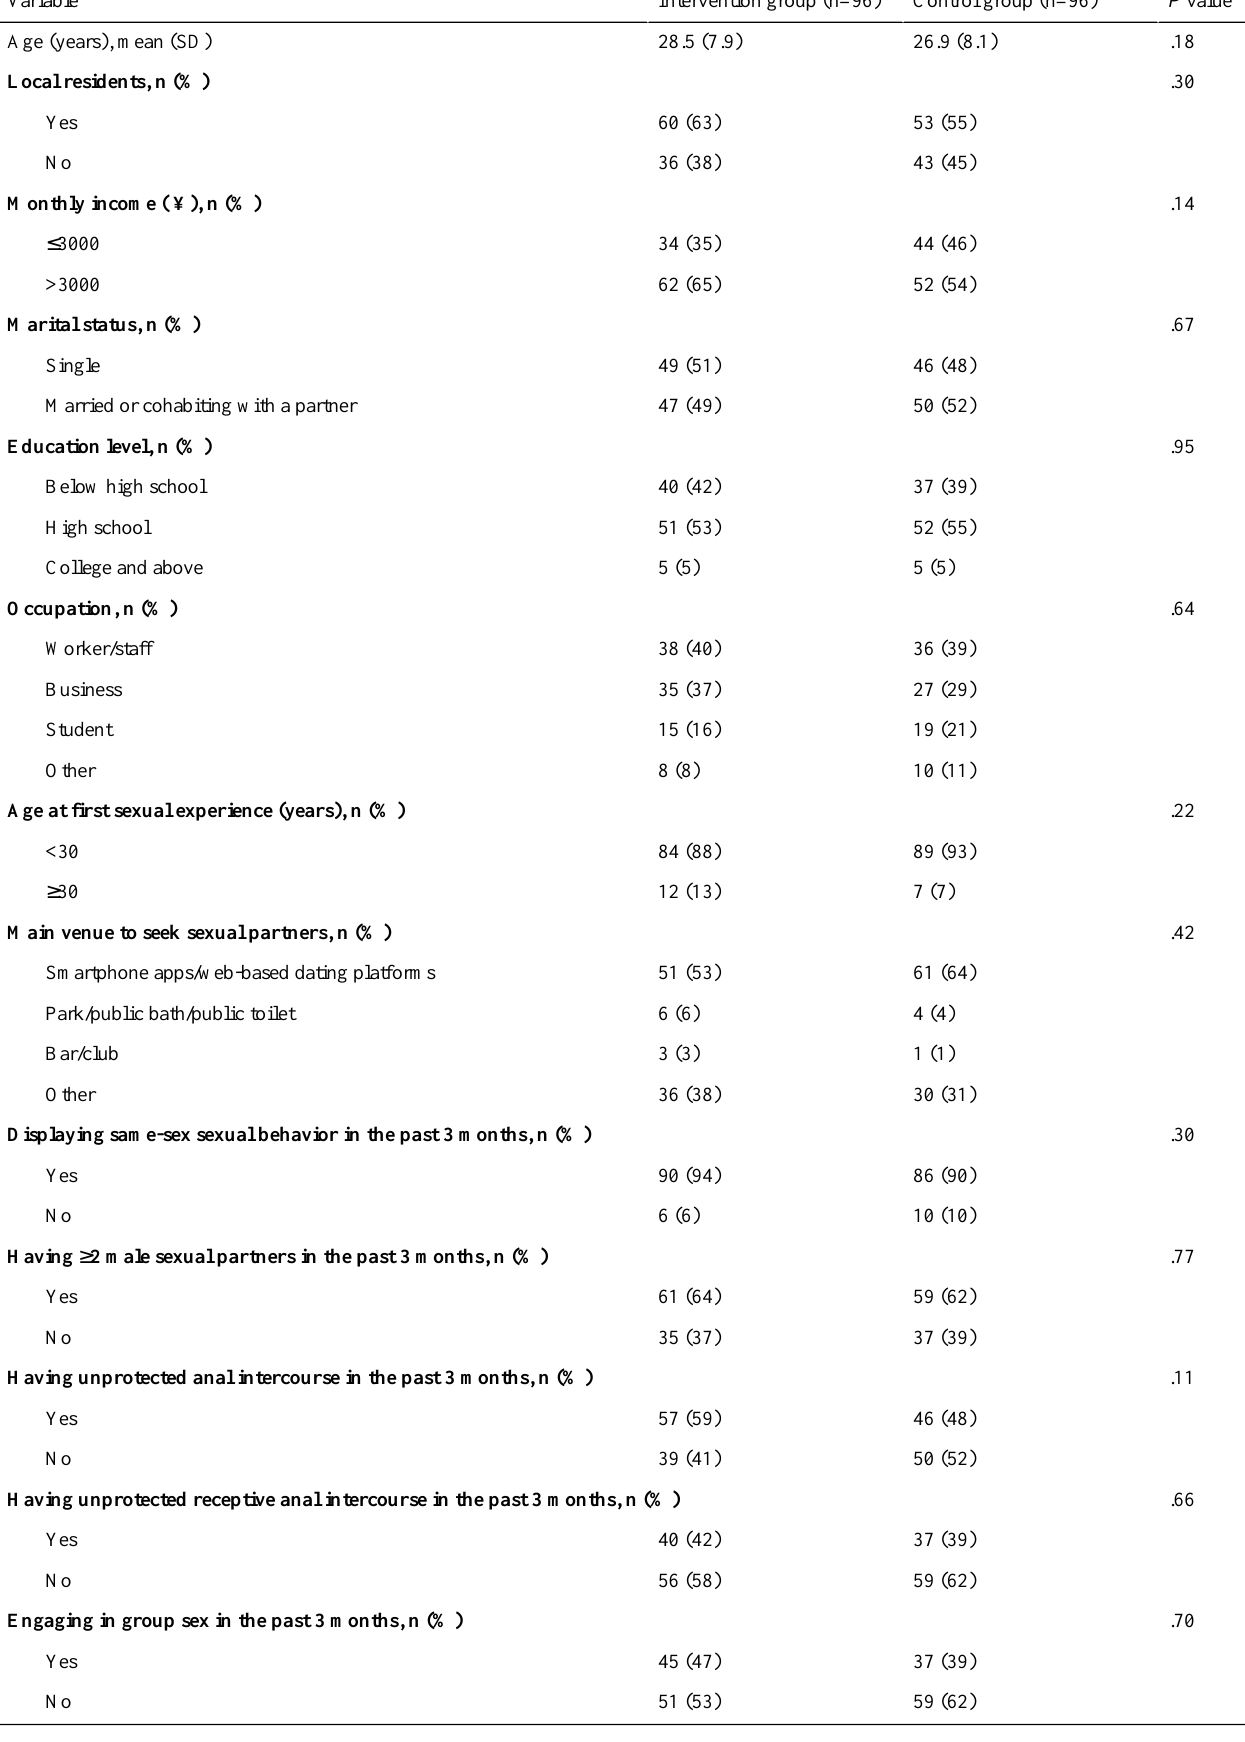
P valueControl group (n=96)Intervention group